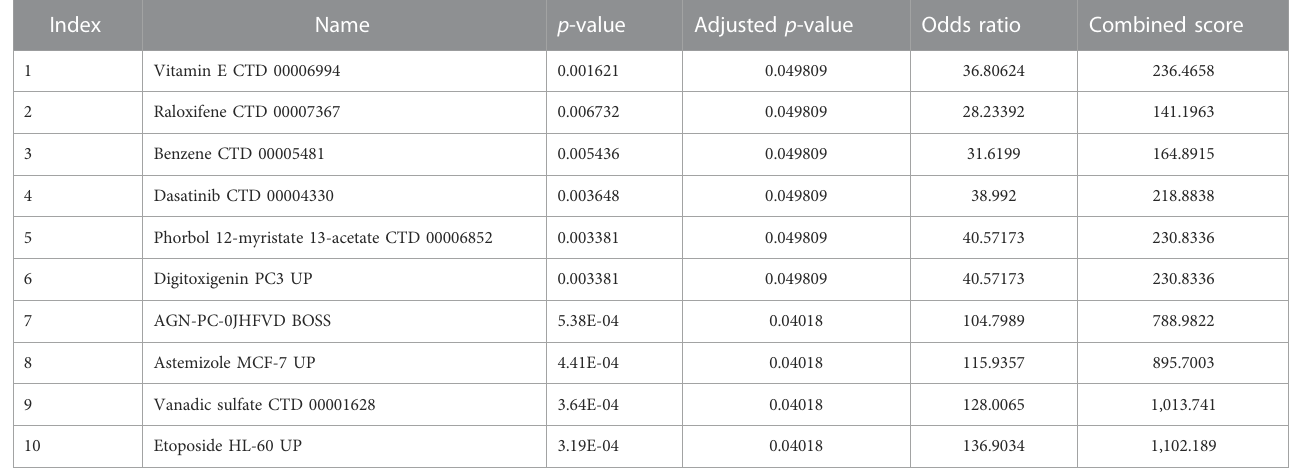
TABLE 2 Candidate drugs of hub genes in the